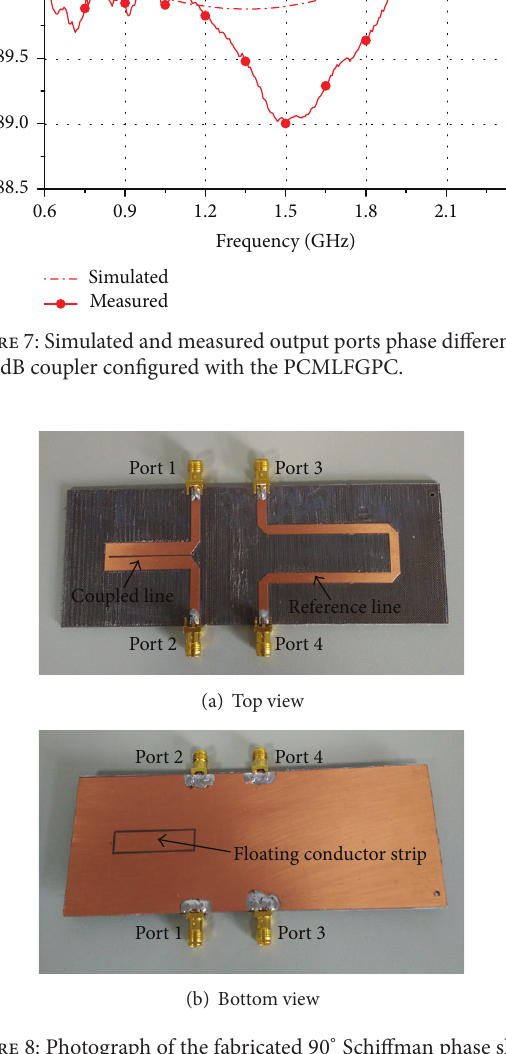
Figure 8: Photograph of the fabricated 90 ∘ Schiffman phase shifter configured with the